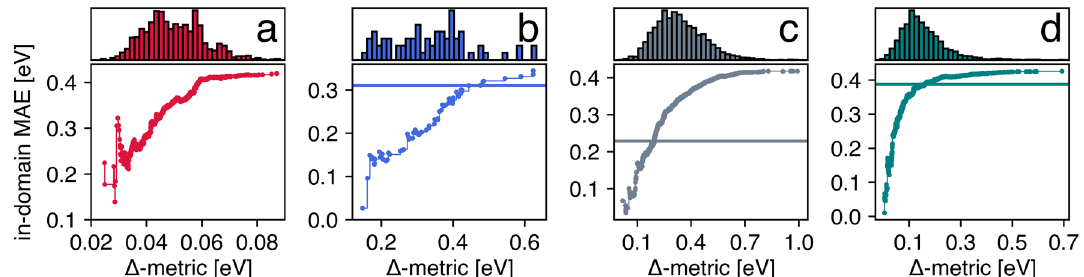
Figure 2. In-domain MAE as a function of the Δ-metric cutoff for the four considered use cases: ( a ) SNUMAT- MEGNet, ( b ) C2DB-GPR-CFID, ( c ) QMOF-KRR-ElemStat, and ( d ) OMDB-RF-PLMF, where the solid horizontal lines indicate the performance of the SOTA models available to